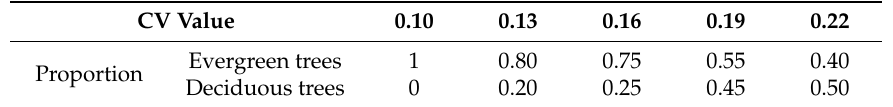
Table 2. Relationship between the coefficient of variation (CV) and the weight of evergreen trees in corresponding pixels. The CV value changes as the proportion of evergreen trees in the pixel